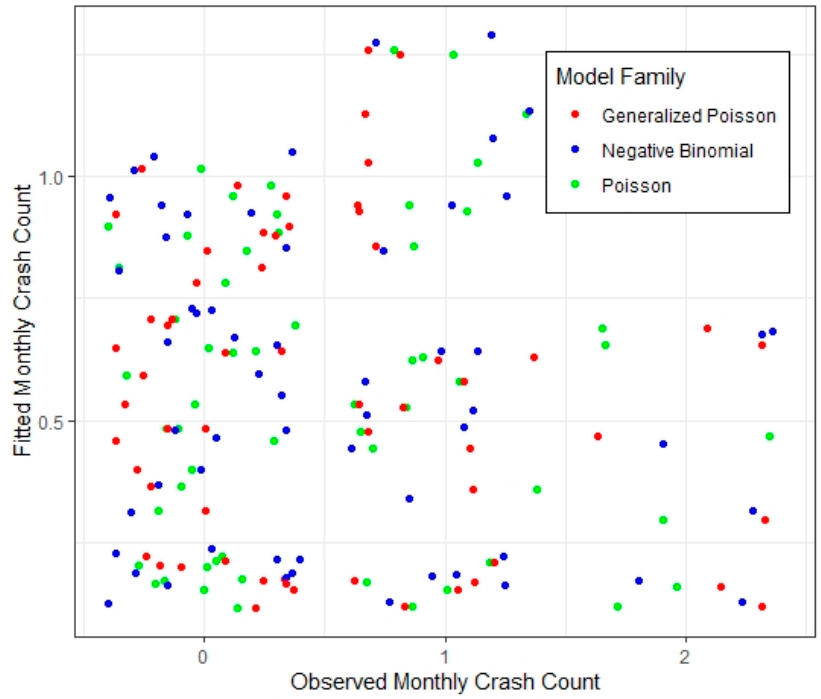
Figure 6. Segment fitted crash counts versus observed crash counts with outliers removed.